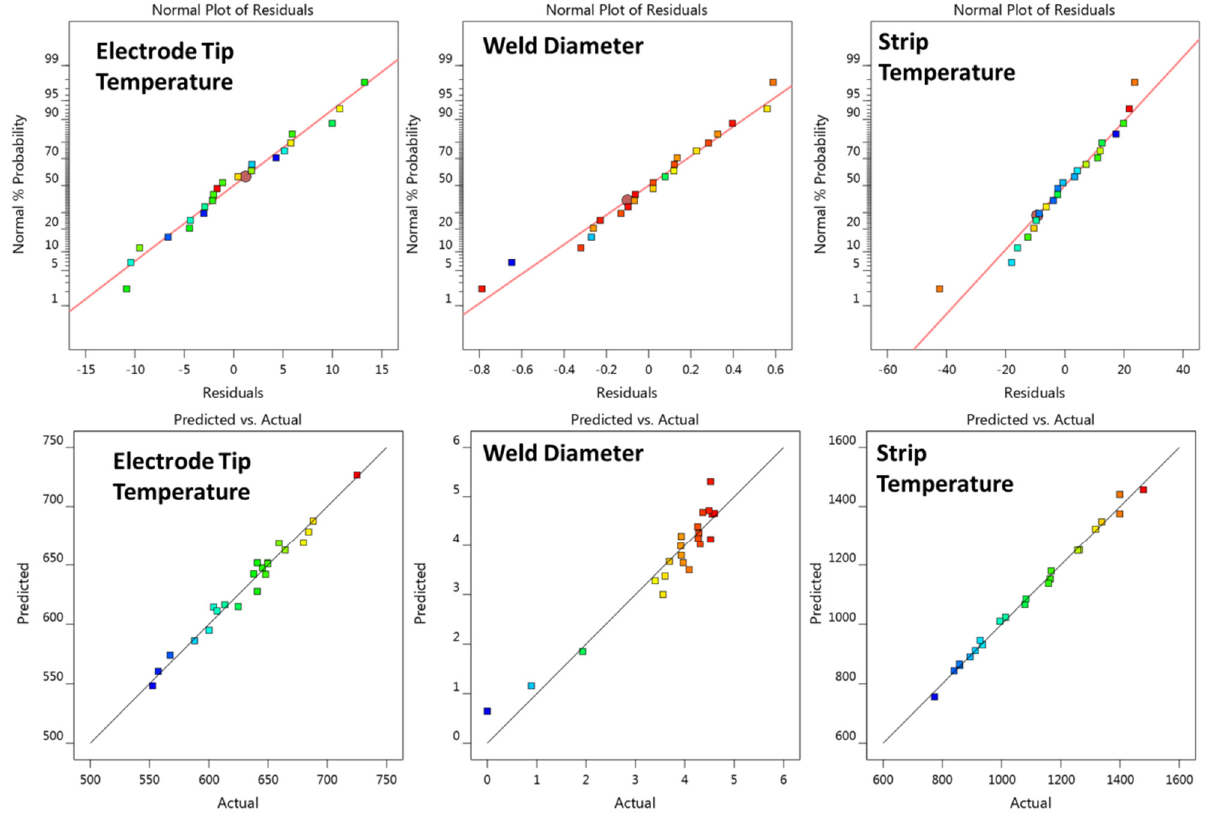
Figure 7. Normal probability plot of residuals and correlation plot of the three regression models.